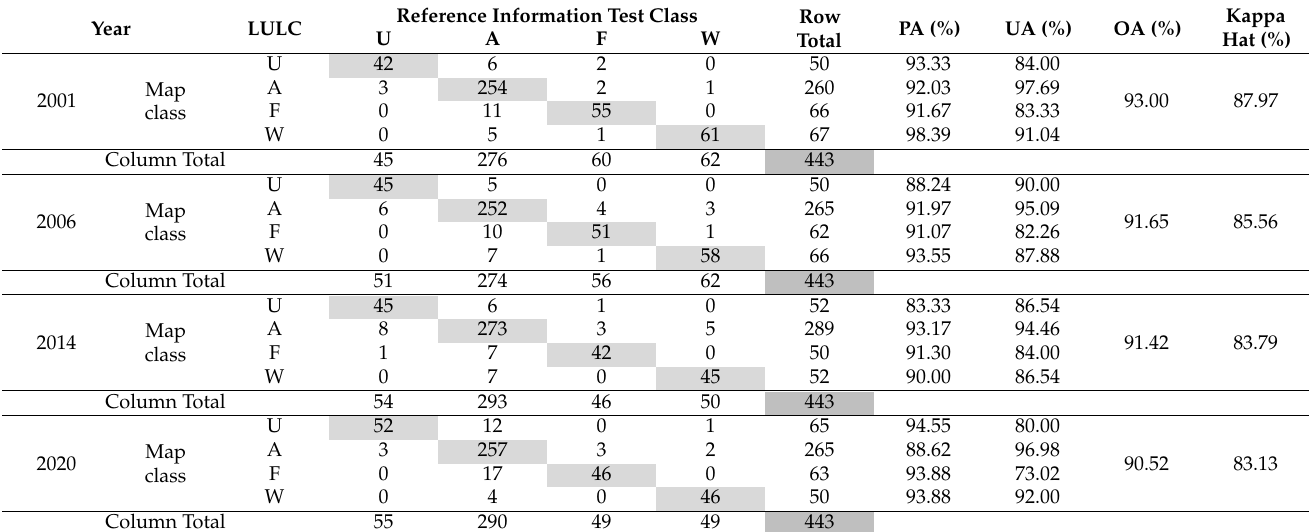
Table 4. Error matrix and thematic accuracy of LULC classification in 2001, 2006, 2014, and 2020.